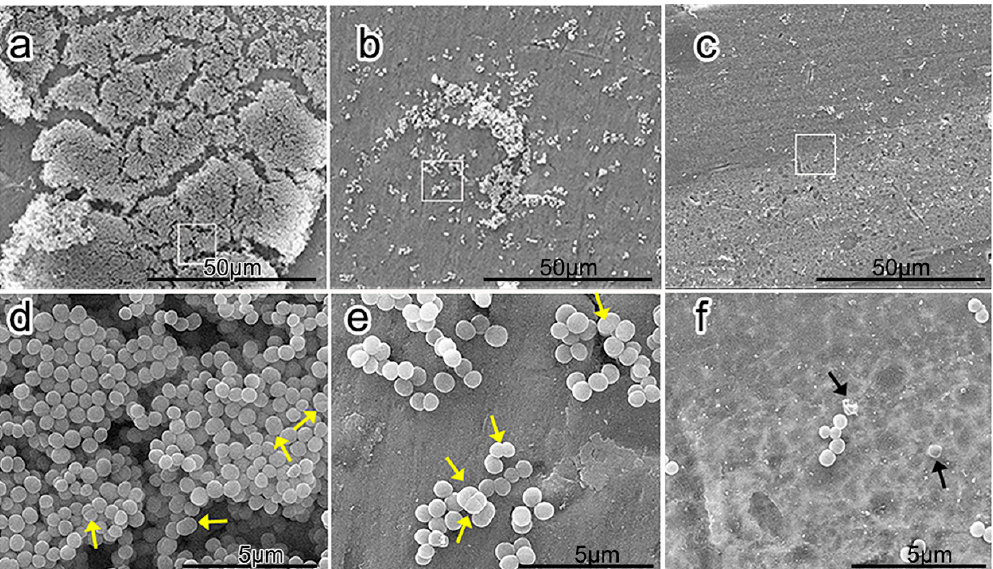
Figure 20. SEM images of S. aureus cells introduced on sample surfaces; ( a – c ) are TC4, 0 mm-FSP, and 2 mm-Ag-FSP at low magnification, respectively, and ( d – f ) are highly magnified images. Yellow arrows show cell fission, whereas black arrows show dead cells with an indistinct or deformed membrane [122]. Reprinted with permission from reference [122] 2018 Elsevier.